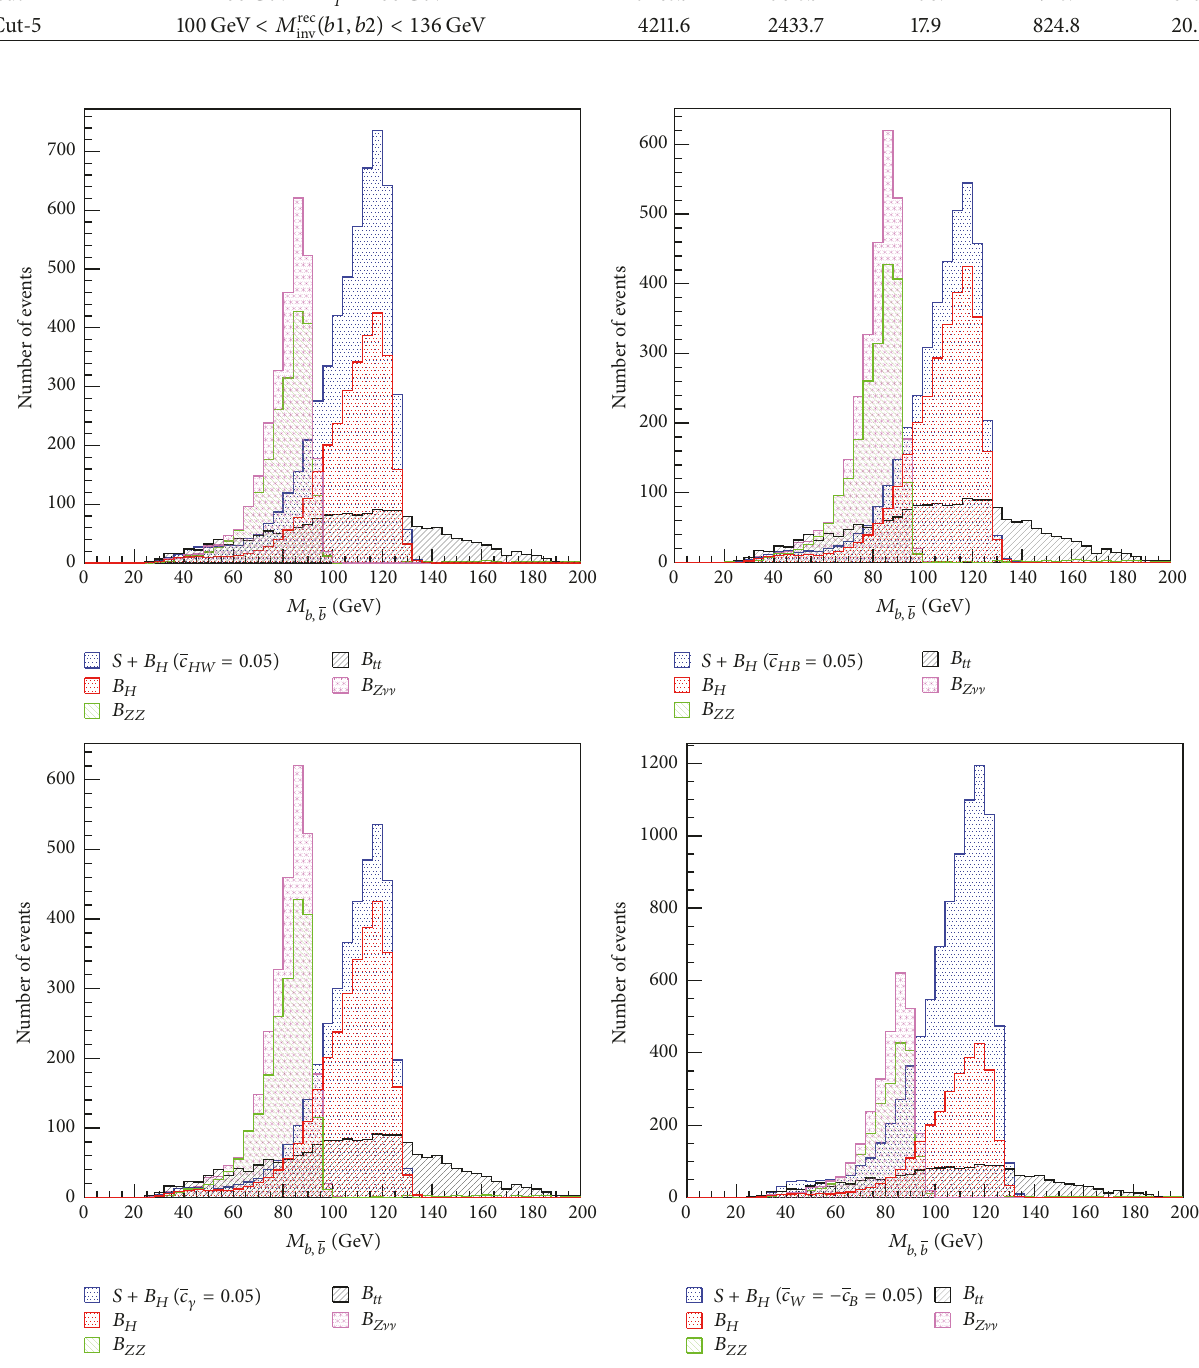
Figure 5: Normalized distributions of reconstructed invariant mass of Higgs boson from 𝑏𝑏 for signal with 𝑐 퐻푊 = 0.05, 𝑐 퐻퐵 = 0.05, 𝑐 훾 = 0.05, and 𝑐 푊 = −𝑐 퐵 = 0.05 and relevant background